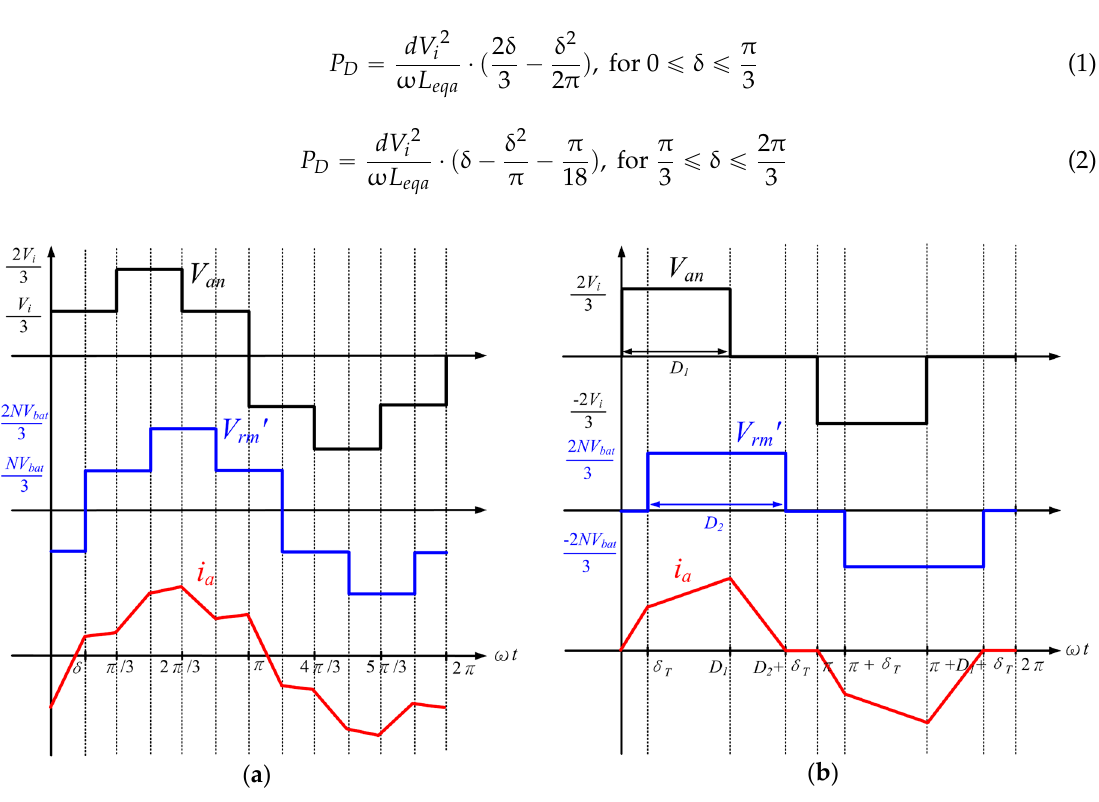
Figure 2. Theoretical waveforms of 3 Φ DAB converter. ( a ) Phase ‐ shifted modulation; ( b ) Trapezoidal modulation.